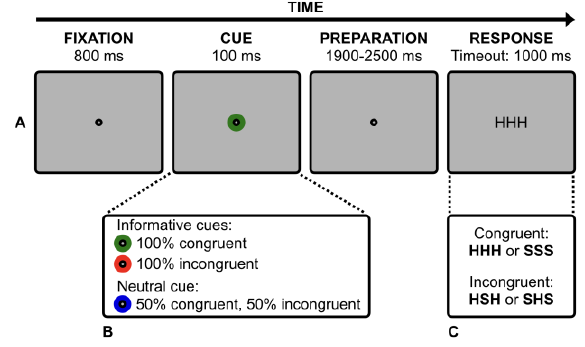
Figure 1 Illustration of the cued-flanker task. Partici- pants maintained fixation on the central spot for the whole duration of the trial. The central cue (i.e., the col- oured ring), provided information concerning the upcom- ing flanker stimulus, and a speeded manual response was required to decide whether the central target letter was either “H” or